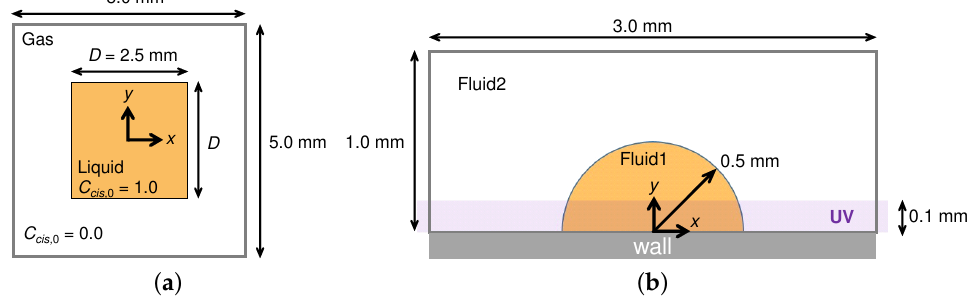
Figure A1. ( a ) Square liquid droplet surrounded by gas without gravity. Initially, the cis isomer ( C cis = 1) dominates in the entire droplet. ( b ) Semisphere droplet on a flat wall to be partially irradiated with UV light that induces cis-trans photoisomerization. Initially, the trans isomer ( C cis = 0) dominates in the entire domain. In this preliminary test, the trans -isomer liquid is assumed to have a contact angle of ϑ trans = 90 ◦ , and a UV-light irradiation area is limited only in the vicinity of the